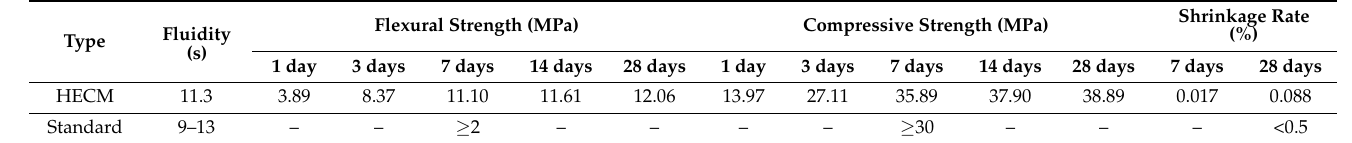
Table 1. Technological parameters of the HECM.